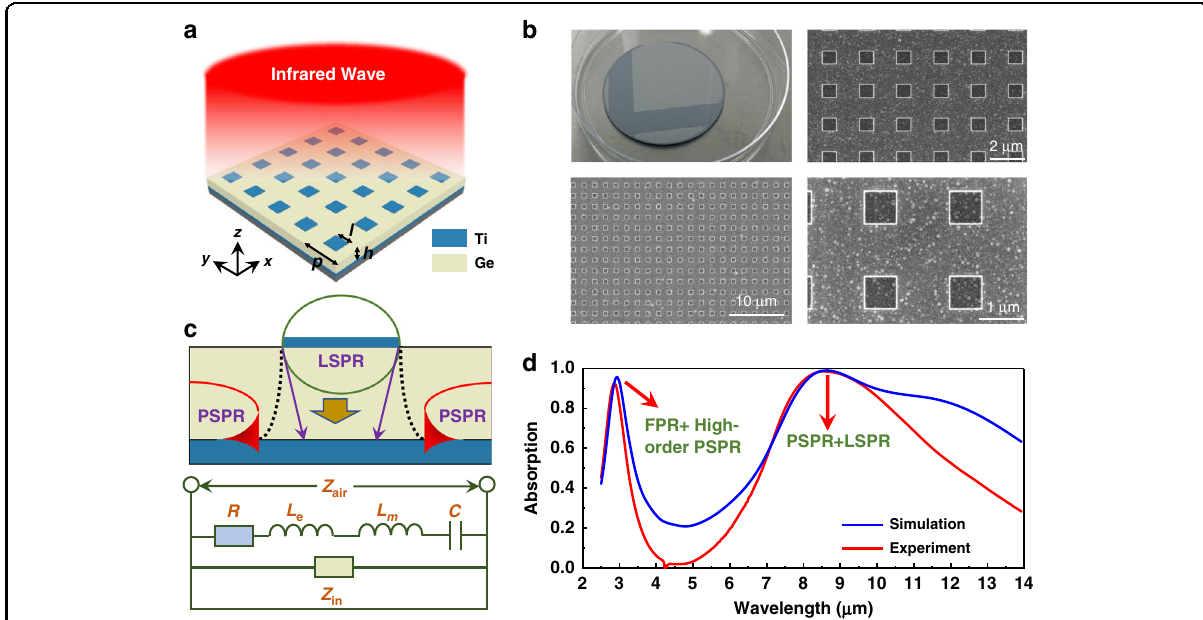
Fig. 1 Absorption characteristics of the Ti/Ge/Ti absorber. a Schematic of the Ti/Ge/Ti absorber with periodic square top resonators. In this design, l = 0.8 μ m, p = 2 μ m and h = 0.5 μ m. The thickness of the top Ti layer is 22 nm, and the bottom Ti layer is 120 nm, where is thicker than its penetration depth. b SEM images of the fabricated Ti/Ge/Ti absorber. c Schematic of different resonant modes and equivalent RLC circuit of the Ti/ Ge/Ti unit cell. d Simulated and experiment absorption spectra of the Ti/Ge/Ti